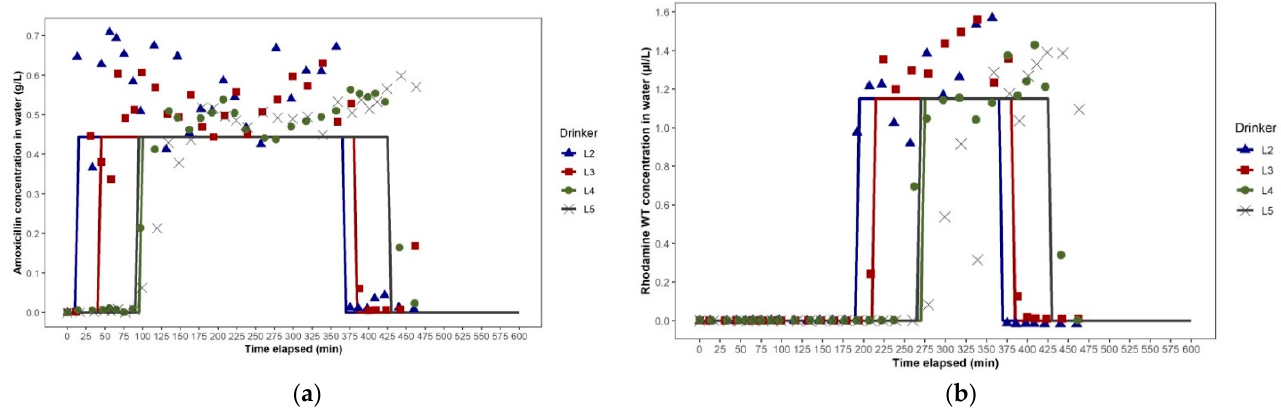
Figure 8. Study 2a dosing event in Building B: ( a ) amoxicillin concentration—time plots for drinkers L2, L3, L4 and L5, as predicted using EPANET (lines) and as observed (points), ( b ) rhodamine WT concentration—time plots for drinkers L2, L3, L4 and L5, as predicted using EPANET (lines) and as observed (points).